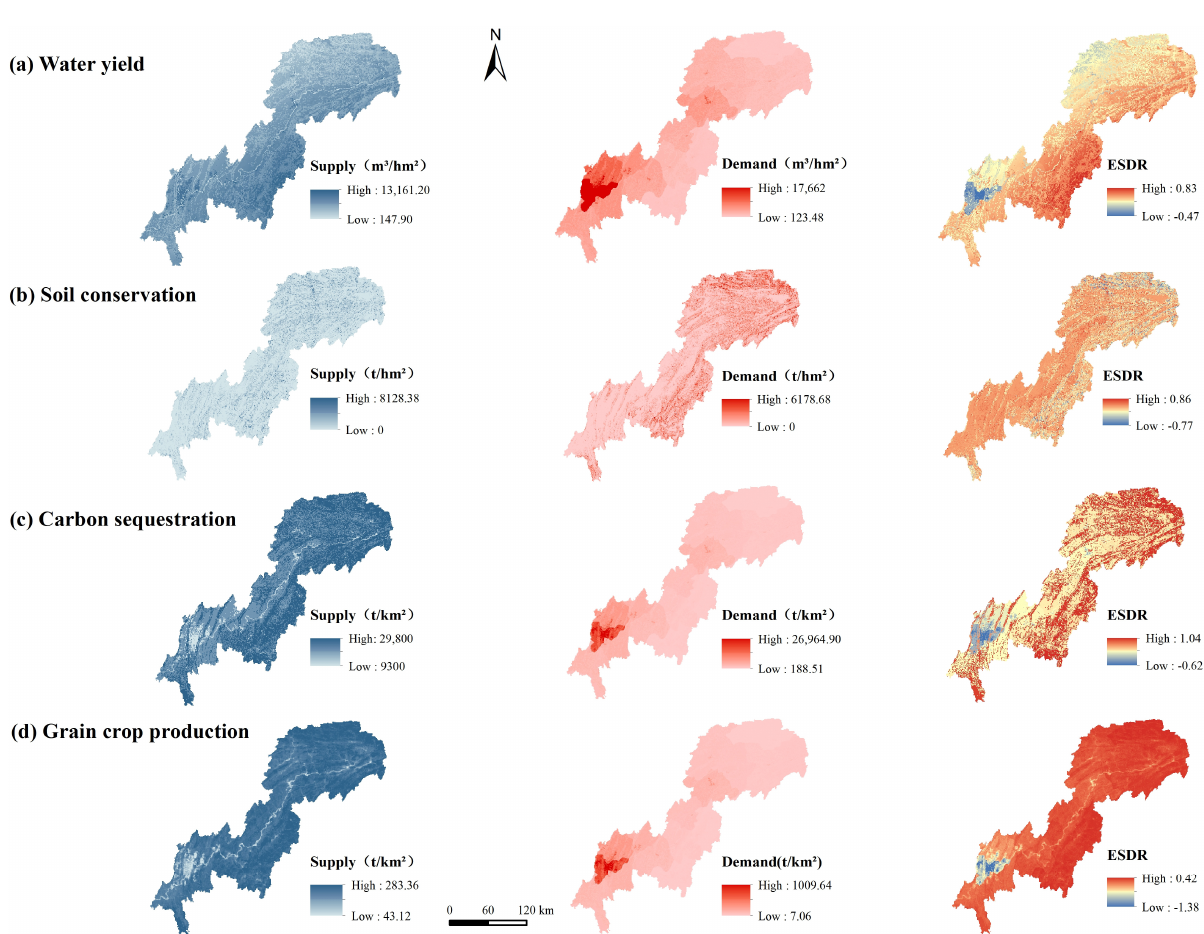
Figure 4. Spatial distribution of supply and demand of ESs.